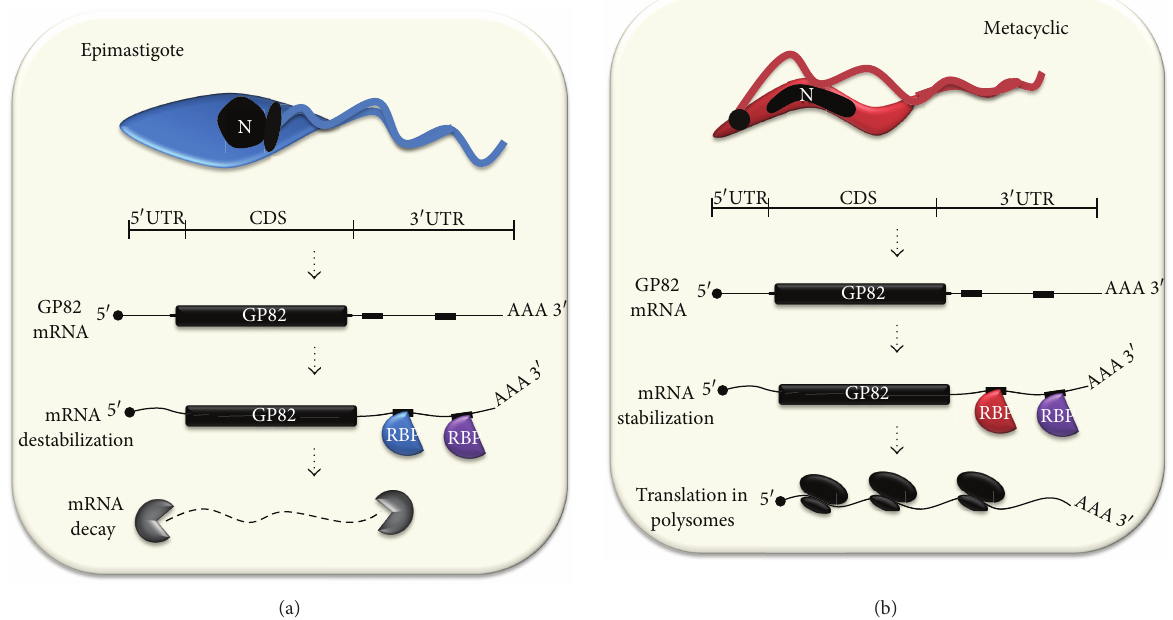
Figure 3: Comparison of GP82 mRNA post-transcriptional control mechanisms in (a) epimastigotes and (b) metacyclic trypomastigotes. In epimastigotes, GP82 mRNA interacts with possibly more than one RNA-binding protein (RBP), which binds to different cis -elements in the 3 󸀠 UTR region (small black rectangles), leading to mRNA destabilization and decay. Conversely, in the metacyclic trypomastigote stage, a different set of RBPs interacts with the cis -elements present in the 3 󸀠 UTR, promoting mRNA stabilization and translation in polysomes.